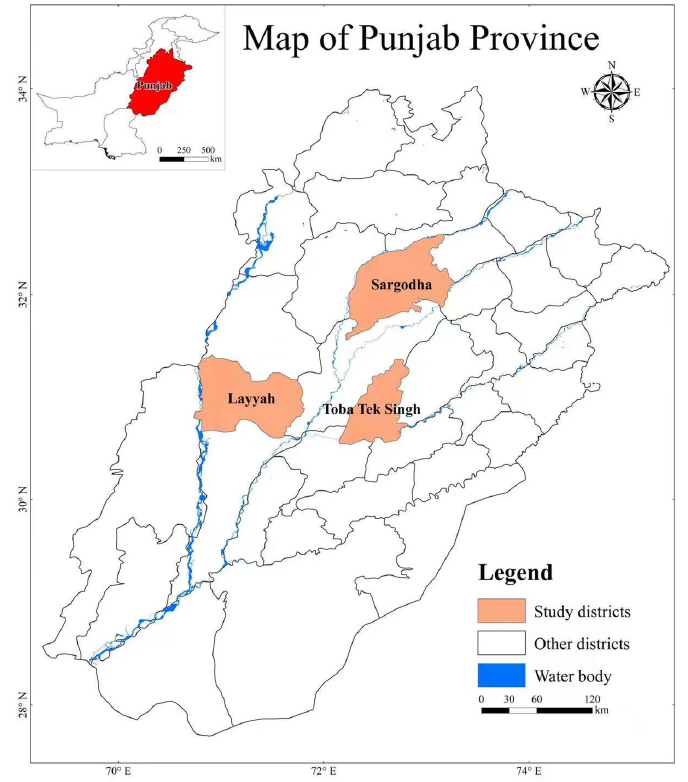
Figure 2. Location of the study area. Source: Authors’ own illustration using ArcGIS software